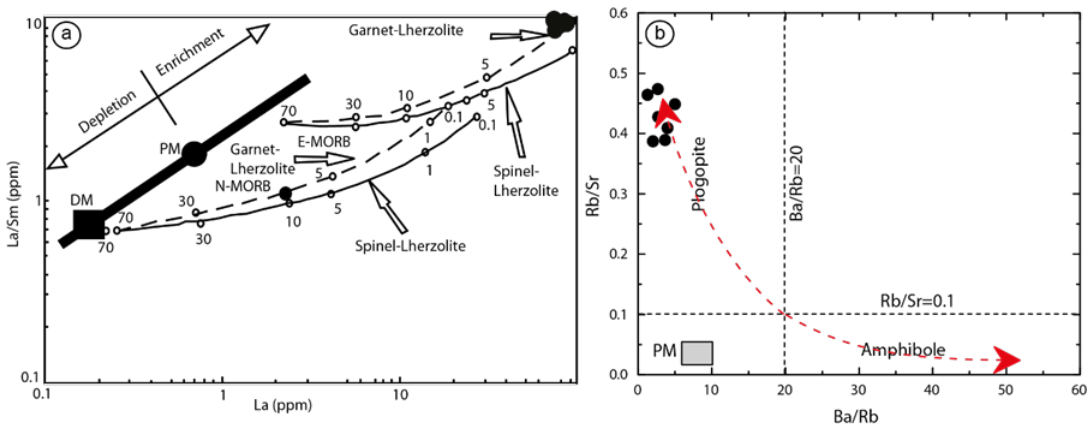
Figure 18. ( a ) Plots of La/Sm vs. La showing modeling of REE abundances and ratios to constrain the source characteristics of the alkaline magma in terms of REE concentrations, source mineralogy and degree of partial melting [72]. The continuous and dashed lines represent different values of partial melting of spinel- and garnet-lherzolite mantle respectively. The lines have numbers indicating the degree of partial melting. Models run for N-MORB and E-MORB; and ( b ) variations in Rb/Sr vs. Ba/Rb ratios that may constrain source mineralogy [59].